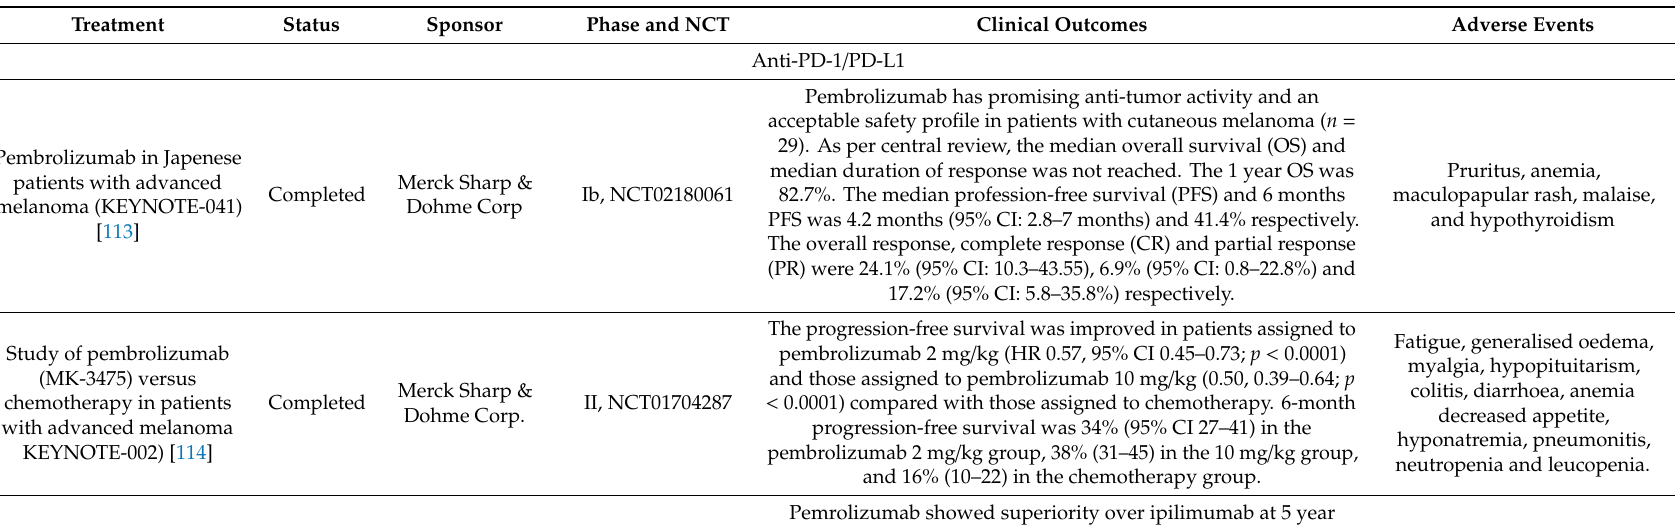
Table 1. Summary of clinical trials, outcomes and adverse events associated with anti-PD-1 / PD-L1, anti-CTLA-4 and their combination in metastatic melanoma